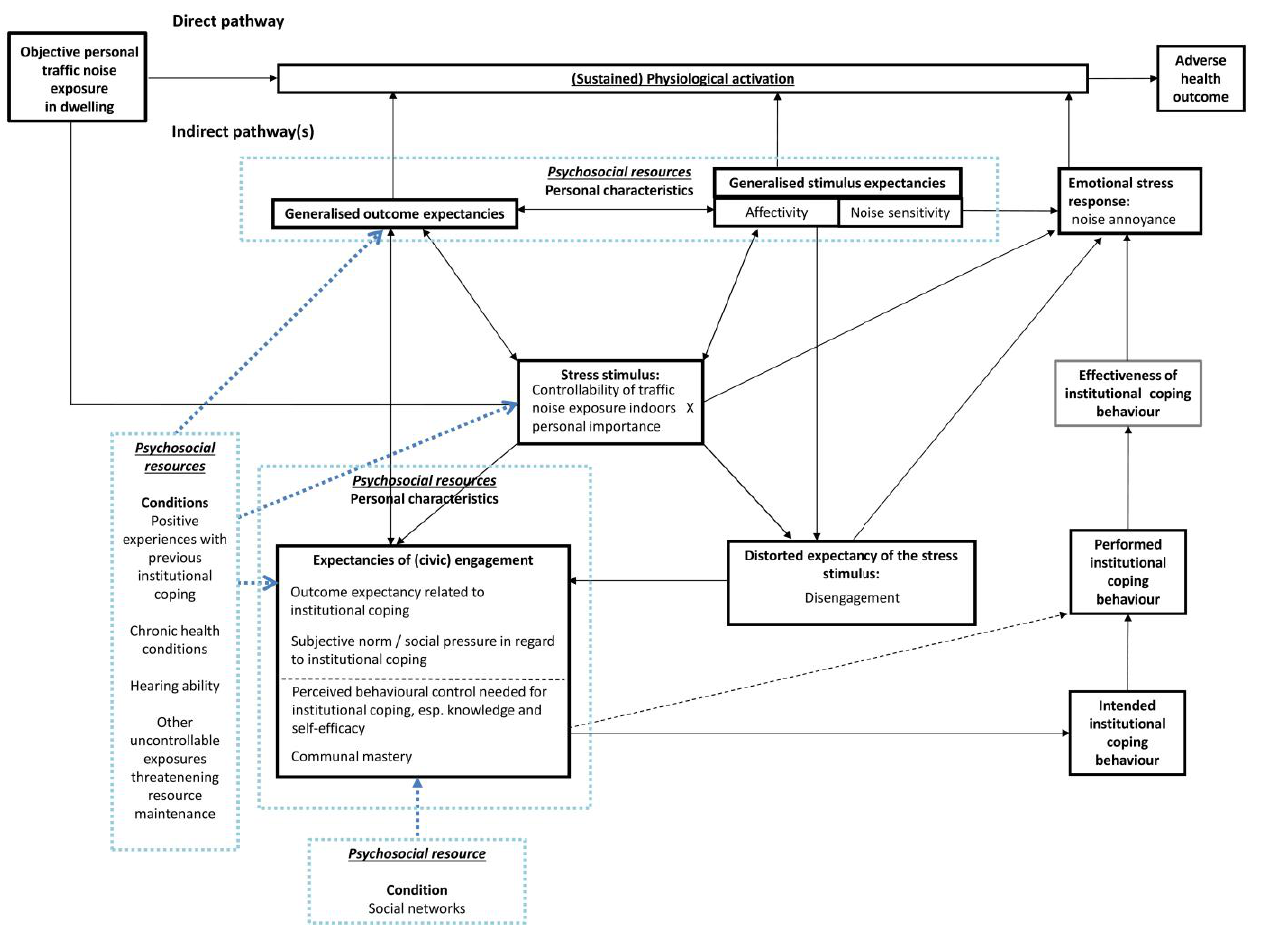
Figure 2. Adding psychosocial resources to our conceptual model.